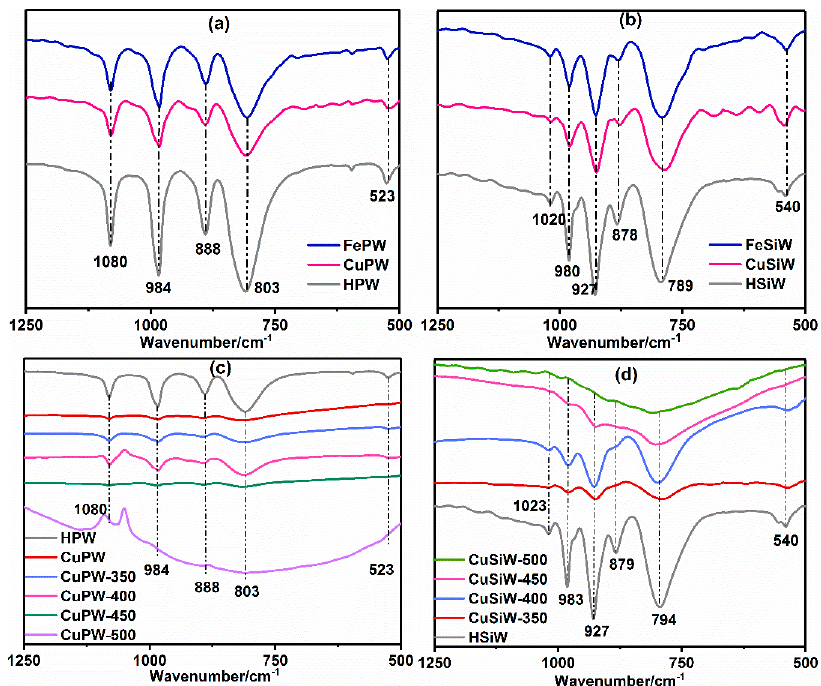
Figure 1. FTIR spectra of the as-synthesized samples: ( a ) HPW, CuPW, FePW; ( b ) HSiW, CuSiW, FeSiW; comparison of ( c ) CuPW samples and ( d ) CuSiW samples calcined at different temperatures under air atmosphere. 350/400/450/500 means samples were calcined at the corresponding temperature.